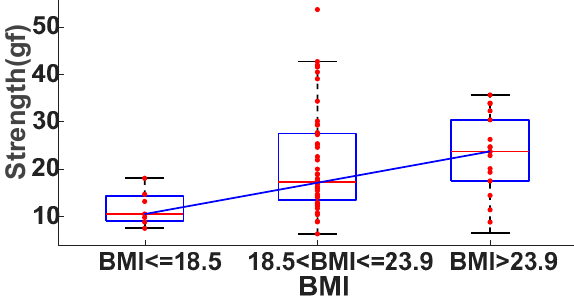
Figure 7. Number of pressurizations–normalized strength curve.